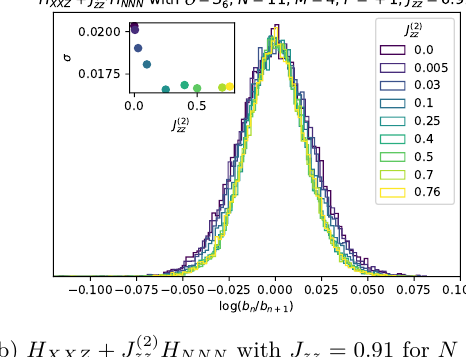
in the M = 6 , P = +1 sector for the operator O = S z + S z . 5 7 Figure 3. Distribution of the log of consecutive ratios of Lanczos coefficients. Inset: standard- deviation σ of this distribution as a function of the corresponding integrability breaking term.